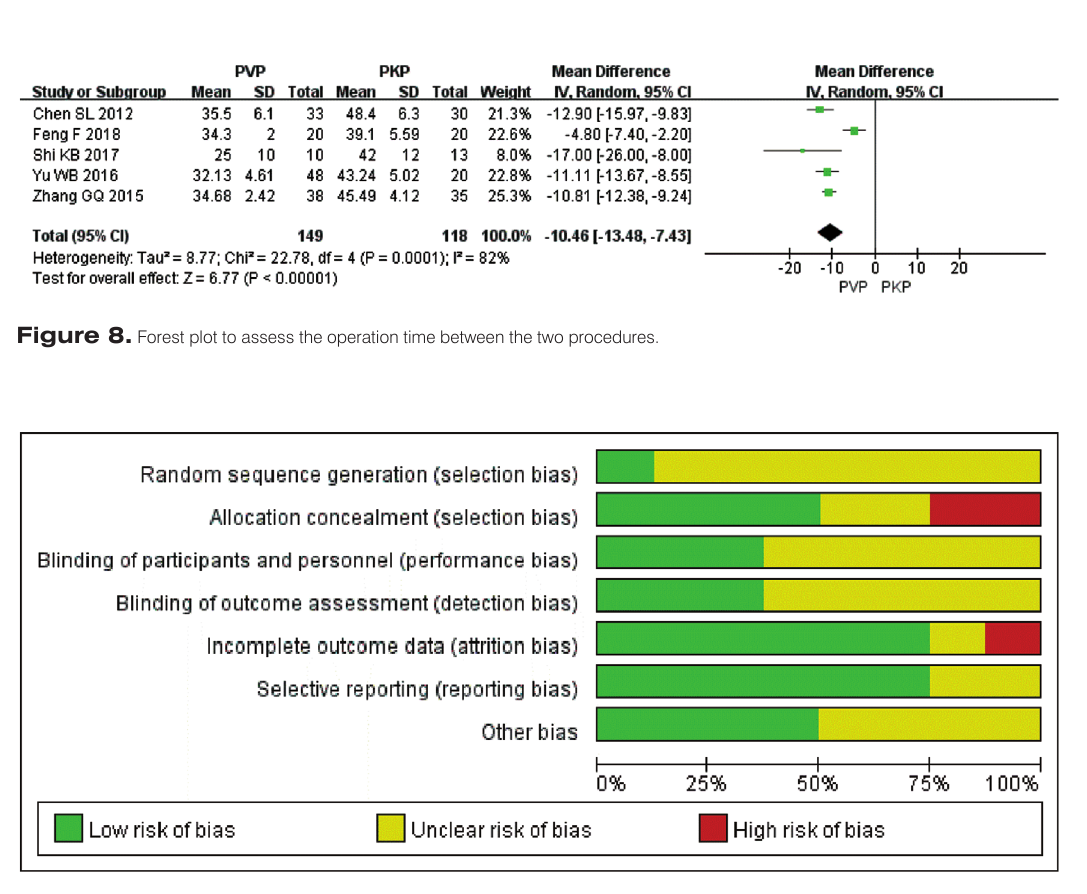
Figure 9. Risk of bias graph.